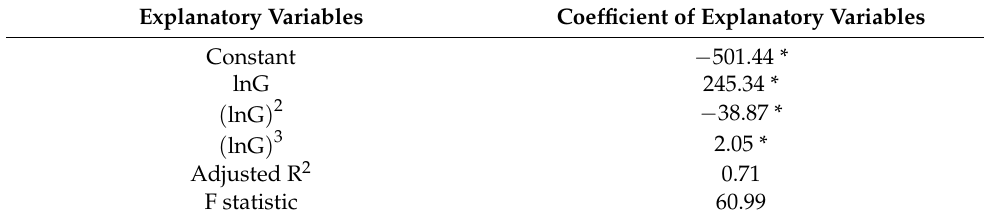
Table 6. Estimation of agricultural CO 2 EKC for Jilin